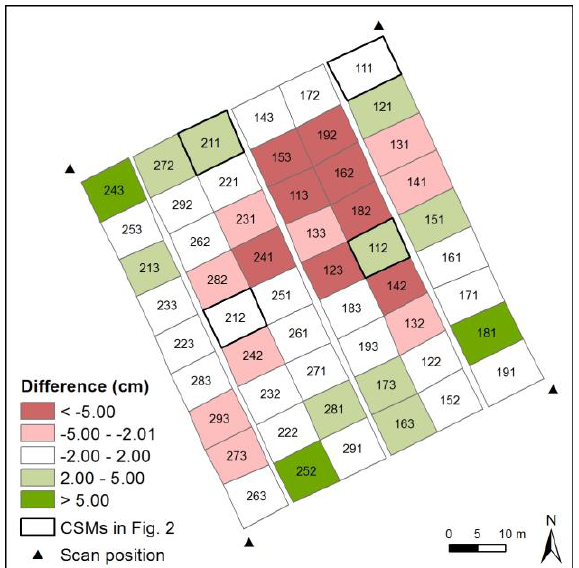
Figure 5. Regression of the mean CSM-derived plant height and the dry biomass for treatment one to five (n =